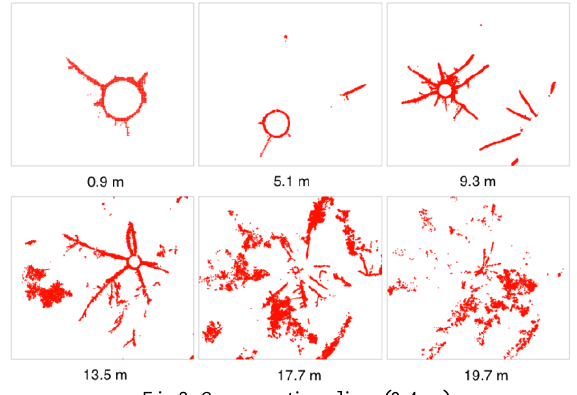
Fig 8. Cross section slices (0.4 m)